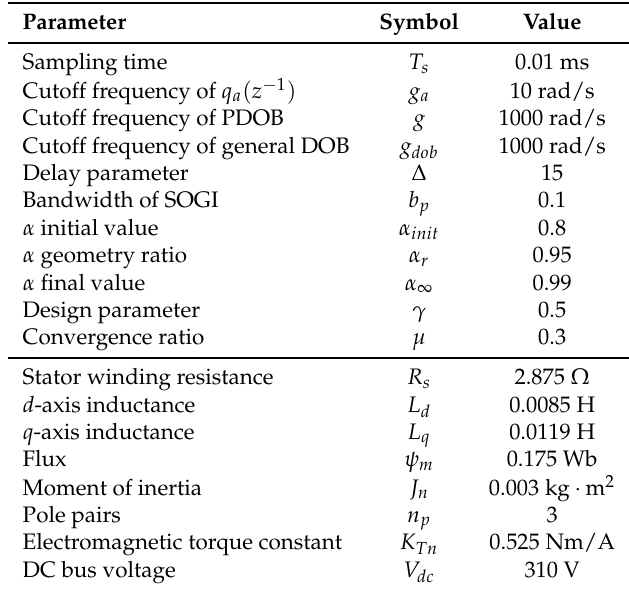
Table 2. Simulation parameters.